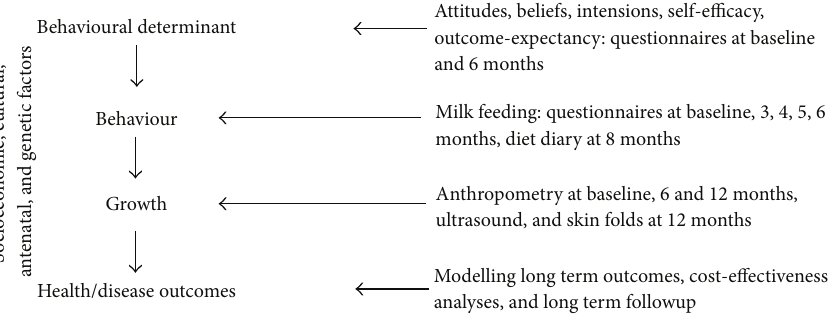
Figure 2: Hypothesised causal pathways and measures for evaluation in the Baby Milk